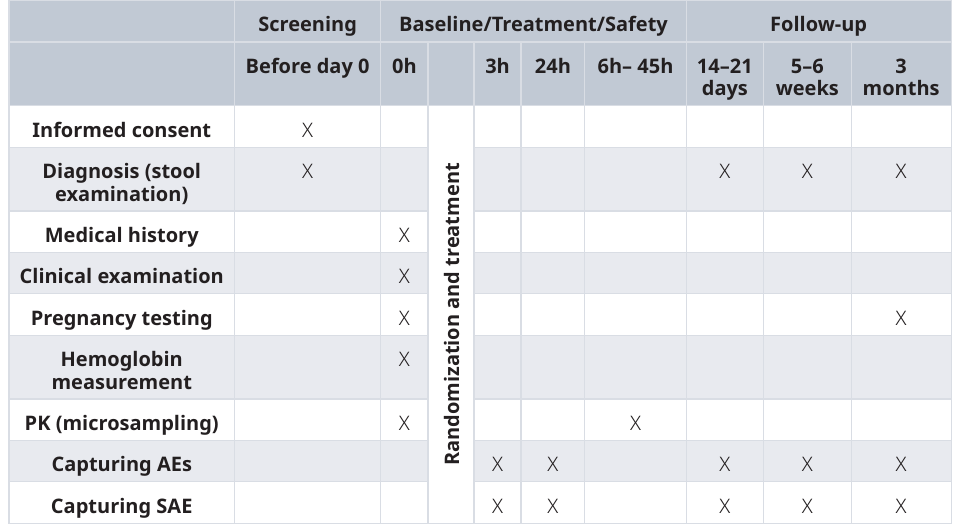
Table 1. Schedule of visits during the study.